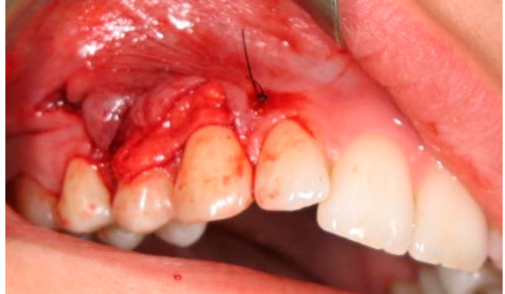
Figure 6. Connective tissue graft placed at the recipient site.